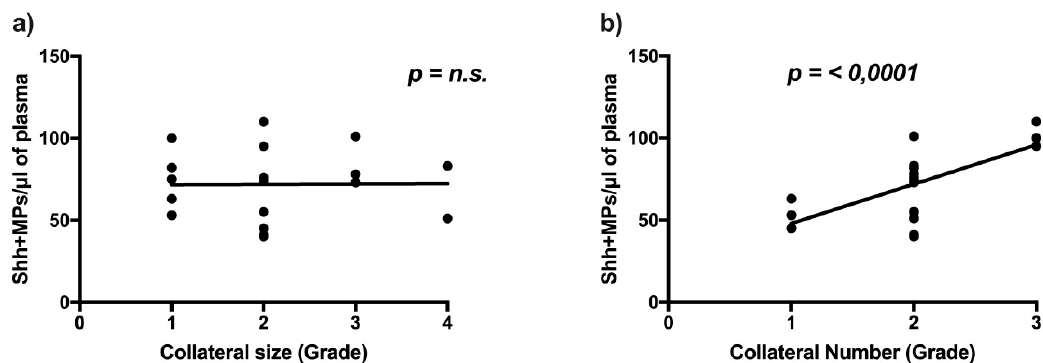
Figure 6. Global number of Shh + MPs in PAD patients according to size ( a ) and number ( b ) of collateral vessels, visualized by the mean of CT angiography. For collateral size, Grade 1 corresponds to ≤ 5 small collateral vessels, Grade 2 to >5 small collateral vessels, Grade 3 to ≤ 5 large ± small collateral vessels, and Grade 4 was defined to >5 large ± small collateral vessels. For collateral number, Category 1 corresponds to 0–3 collateral vessels, Category 2 to 4–7 collateral vessels, and Category 3 to ≥ 8 collateral vessels. Black horizontal lines in panels indicate the interpolate curve.